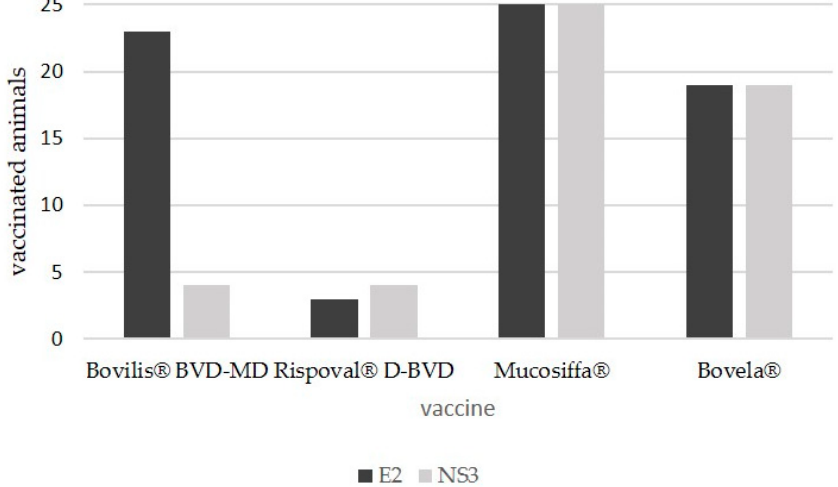
Figure 2. Frequency distribution of vaccinated animals tested positive for bovine viral diarrhoea virus (BVDV) structural (E2) and non ‐ structural (NS3) proteins.